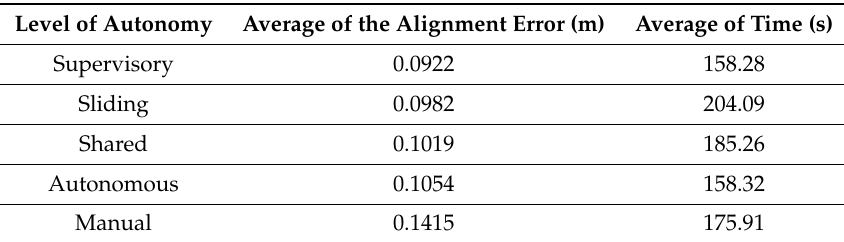
Table 10. Summary of the Experiment